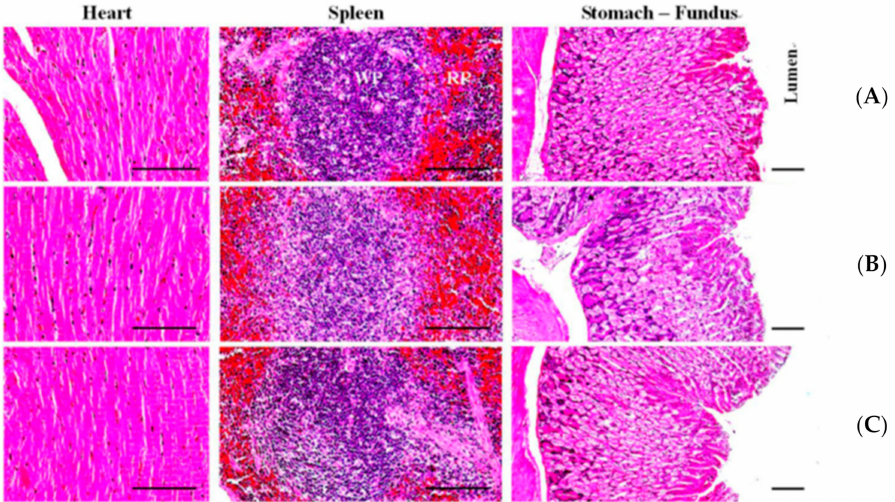
Figure A2. Representative histopathological profiles of the heart, spleen, and stomach tissues: ( A ) normal diet control ( n = 7); ( B ) voglibose ( n = 7); ( C ) enzyme mixture ( n = 7). WP, white pulp; RP, red pulp. Scale bars: 100 µ